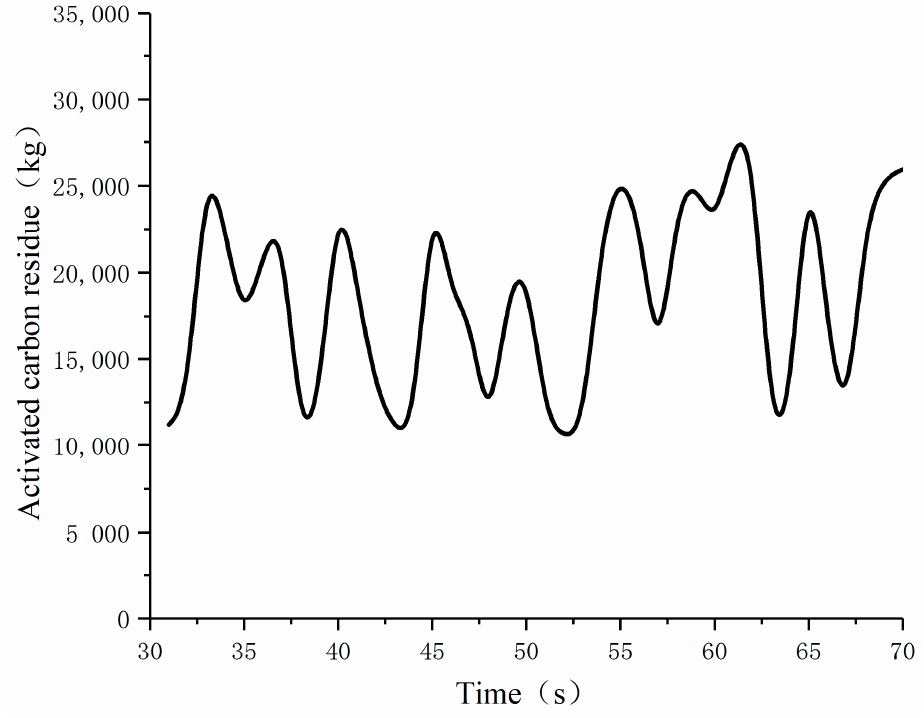
Figure 27. Dynamic change of residual char (30~70 s).